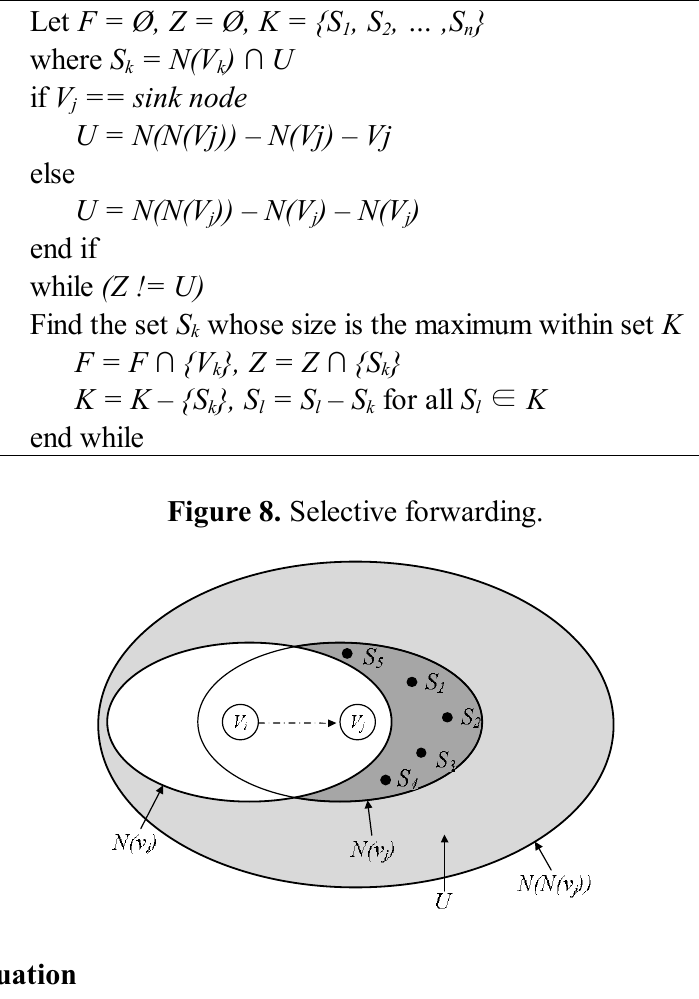
Algorithm 1. Selective forwarding.